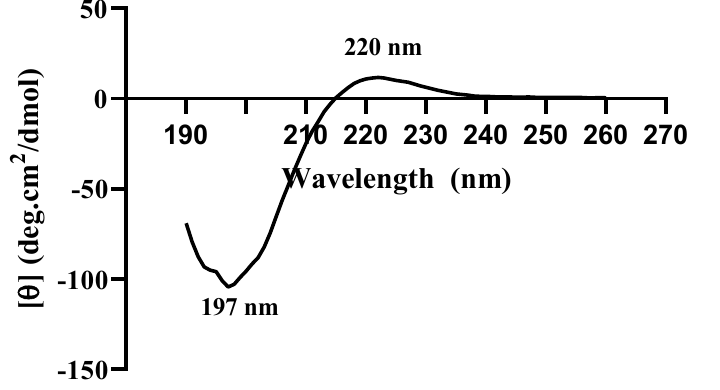
Figure 1 . CD spectrum of collagen sponge implant . Figure 1. CD spectrum of collagen sponge